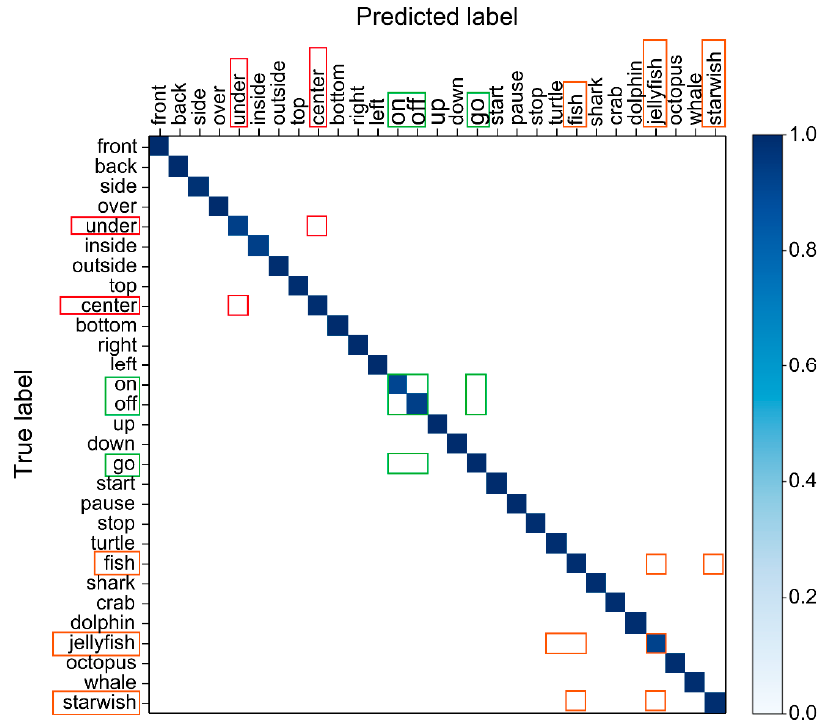
Figure 12. Confusion matrix of the model that proposed many misclassifications out of 53 classes.